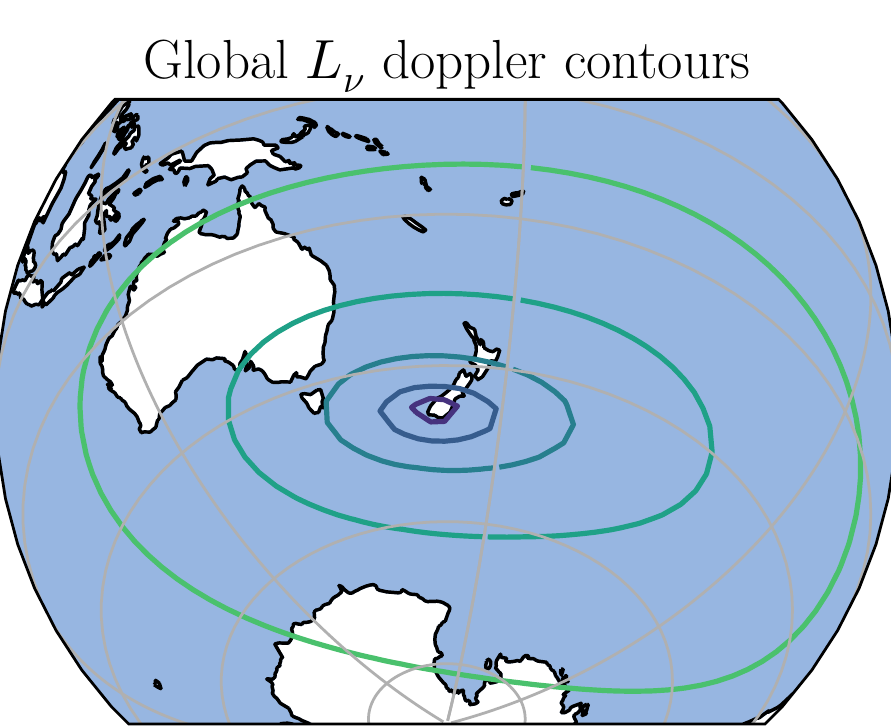
Figure 3. Global Doppler least-squares contours of L ν . This shows a global minimum close to the receiver position in New Zealand. This map is an orthographic projection of the globe, centered over New Zealand at longitude 170°, and latitude 45° south. The grey lines are 30° intervals in longitude and latitude.